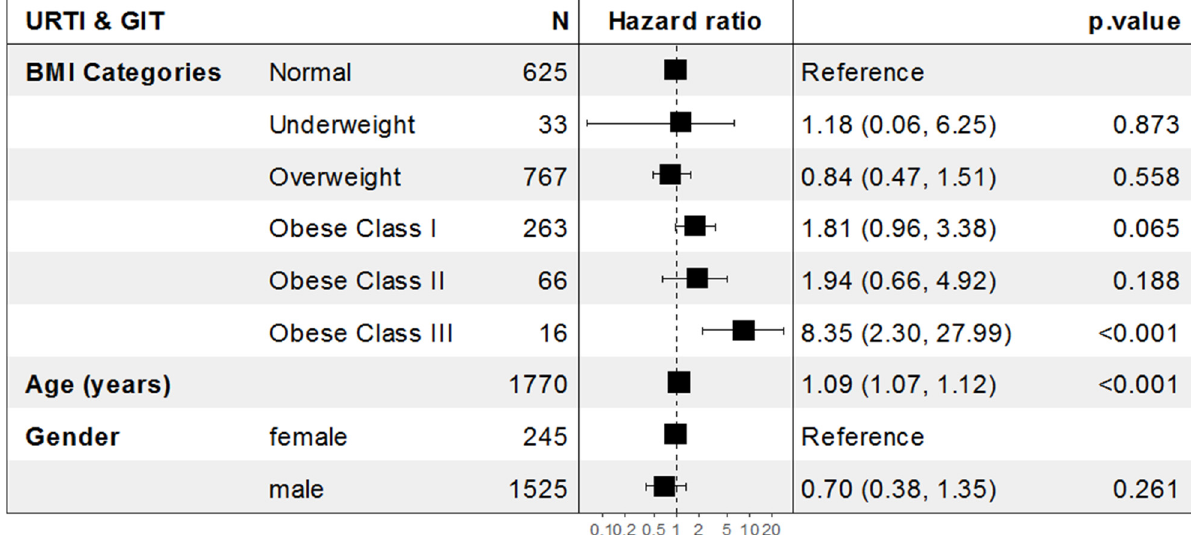
Figure 7. Forest plot for the association between BMI and the incidence of upper respiratory tract infection and gastrointestinal symptoms among hospitalized COVID-19 patients. BMI: body mass index; CI: confidence interval; URTI: upper respiratory tract infections; GIT: gastrointestinal tract infections; OR: odds ratio.